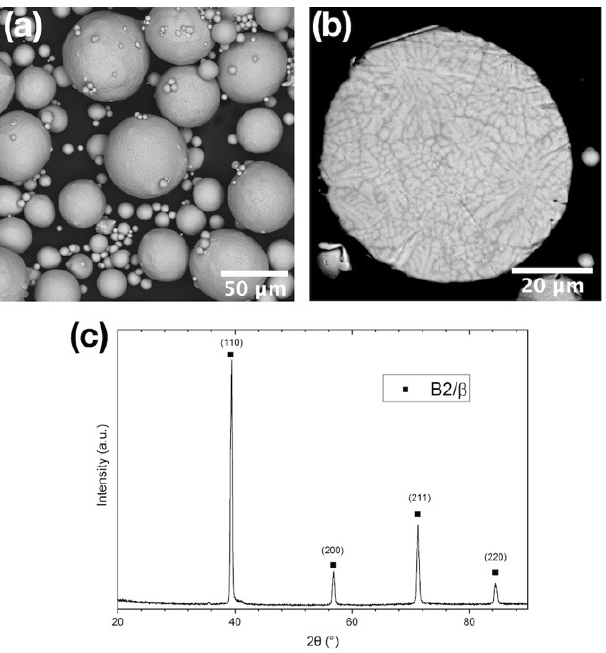
Figure 1. SEM images of the Ti 2 AlNb-CYB powder showing ( a ) particles’ surface morphology and ( b ) their cross-section. The XRD pattern of the powder ( c ).